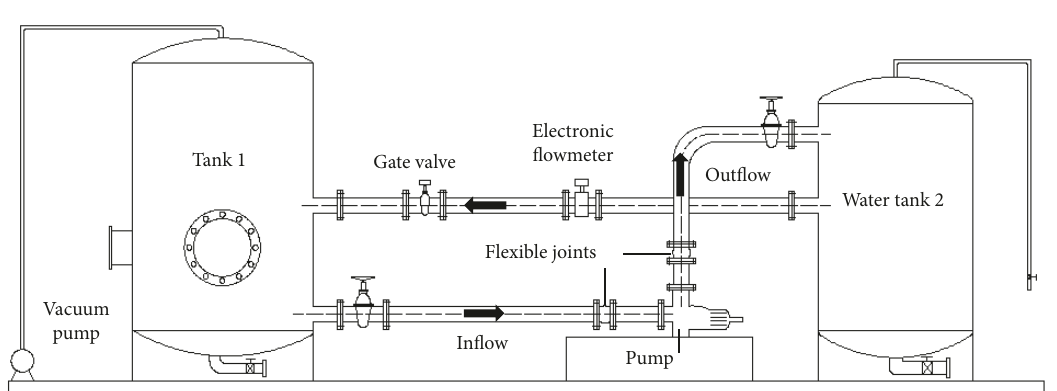
Figure 1: Closed test platform.